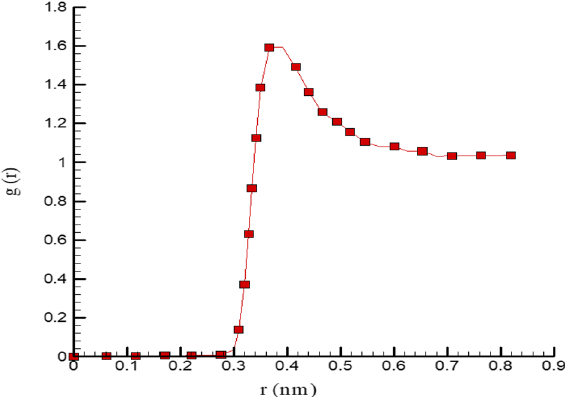
Figure 4. RDF curve of Ar fluid at T = 300 K as initial